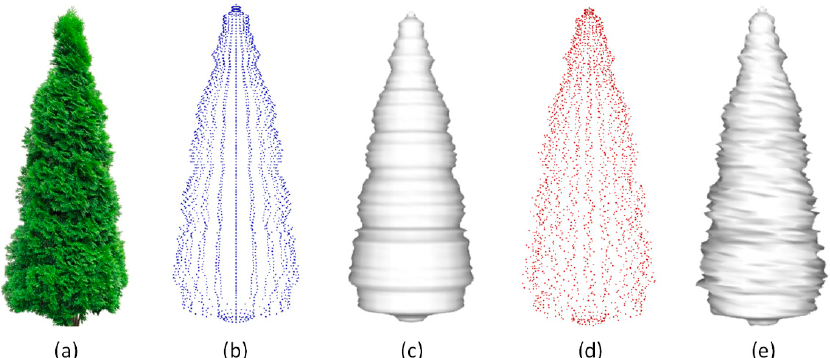
( b ) geometric outlines of the tree crown created from multiple images taken from different viewpoints.